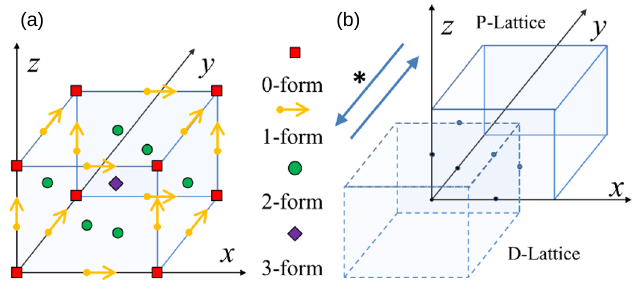
Figure 1 . DEC based discretization of the LCFT for Dirac-Maxwell systems on a rectangular lattice. (a) Discrete forms on the space-like submanifold. (b) Staggered lattice generated by the Hodge dual operator *, where P- indicates primary lattice and D- indiactes dual